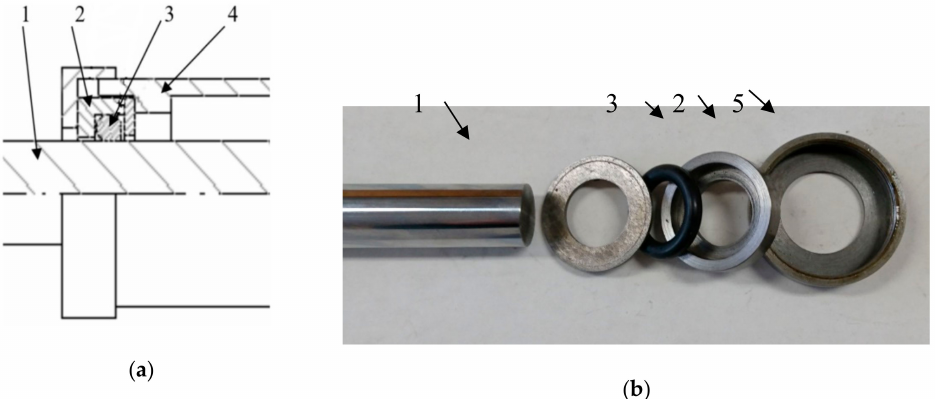
Figure 1. General view of the test stand; 1—rod; 2—chamber; 3—force transducer.